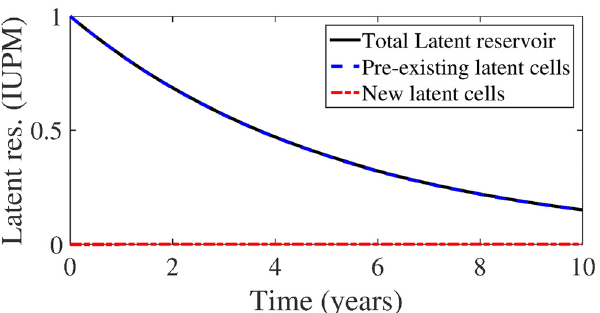
Fig 5. Total latent reservoir size (black, solid line) with pre-existing portion (blue, dashed lines) and new latent cell infections (red, dash-dotted line) for latent cell fraction f = 10 − 4 and drug efficacy ε = 0.6 (reproductive ratio R = 0.92), assuming δ = 1 day − 1 and t 1/2 = 44